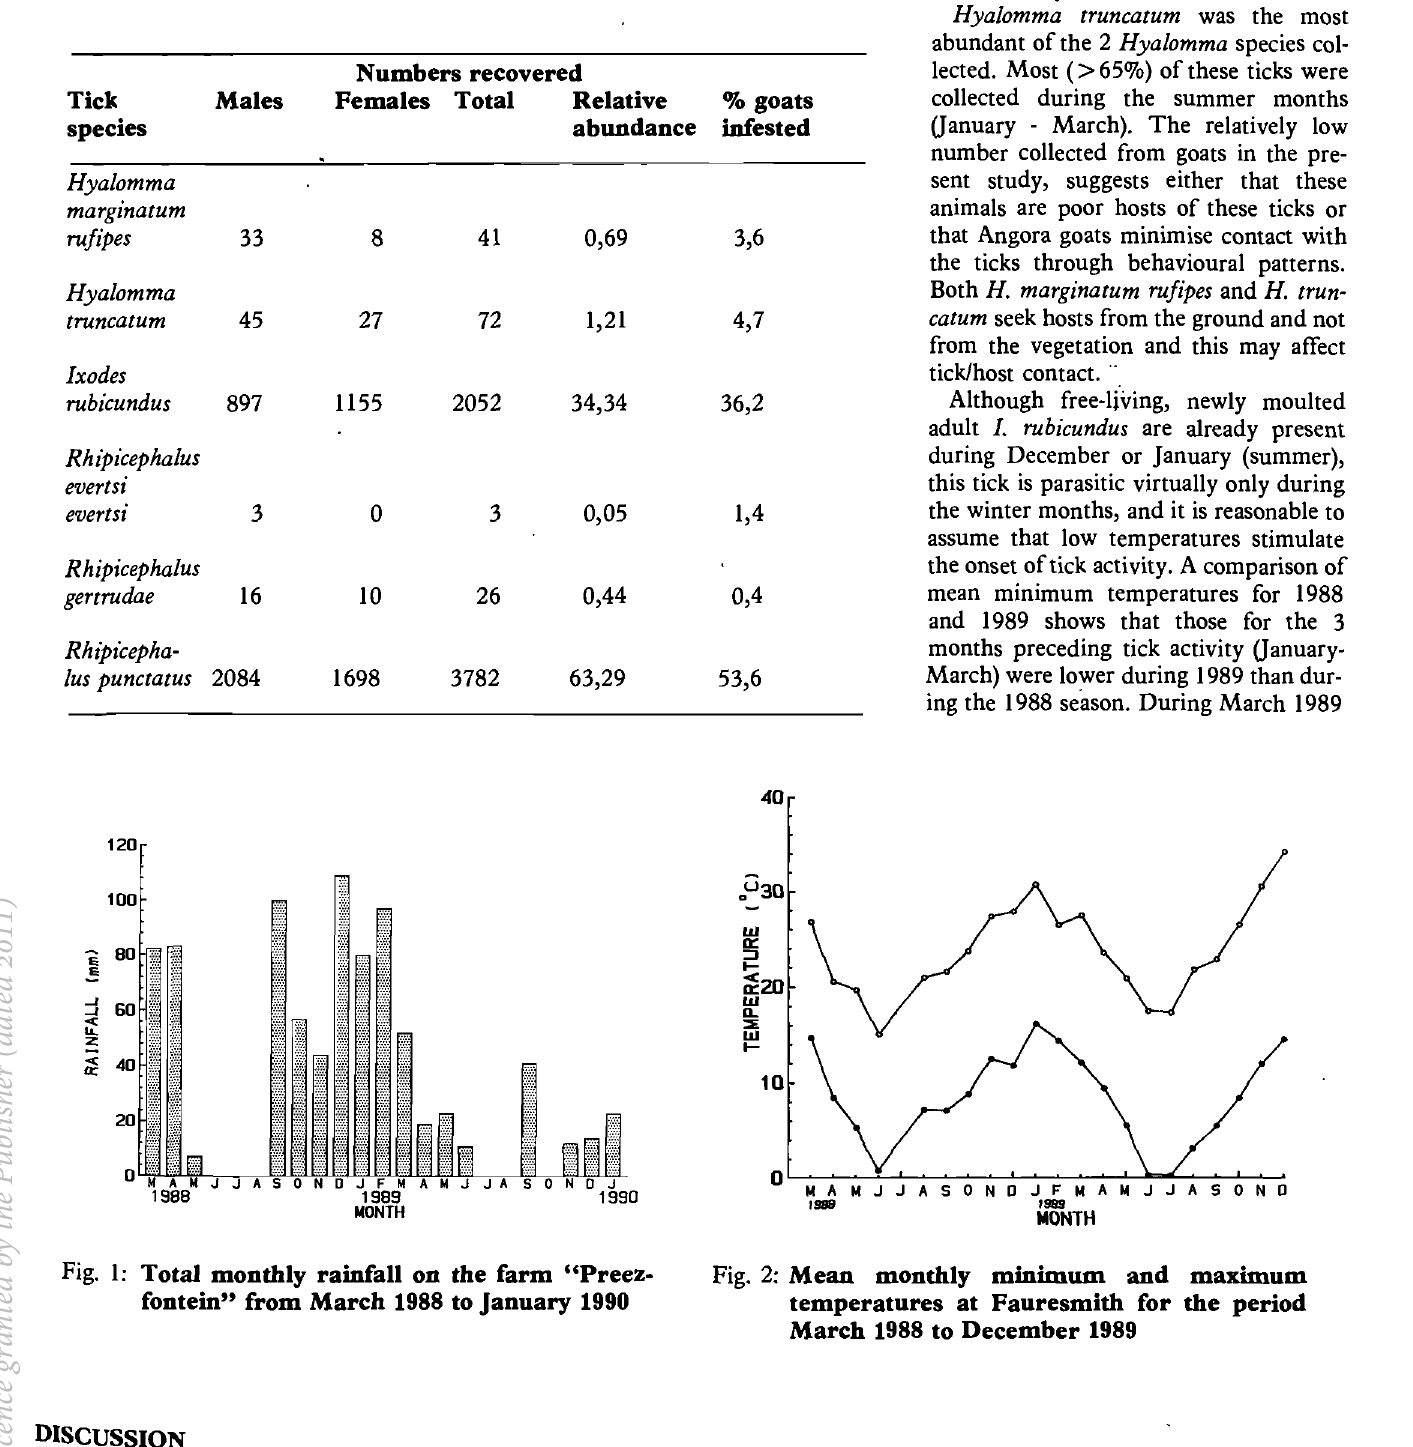
Table 1: Adult ixodid ticks collected from Angora goats on the farm "Preezfontein"